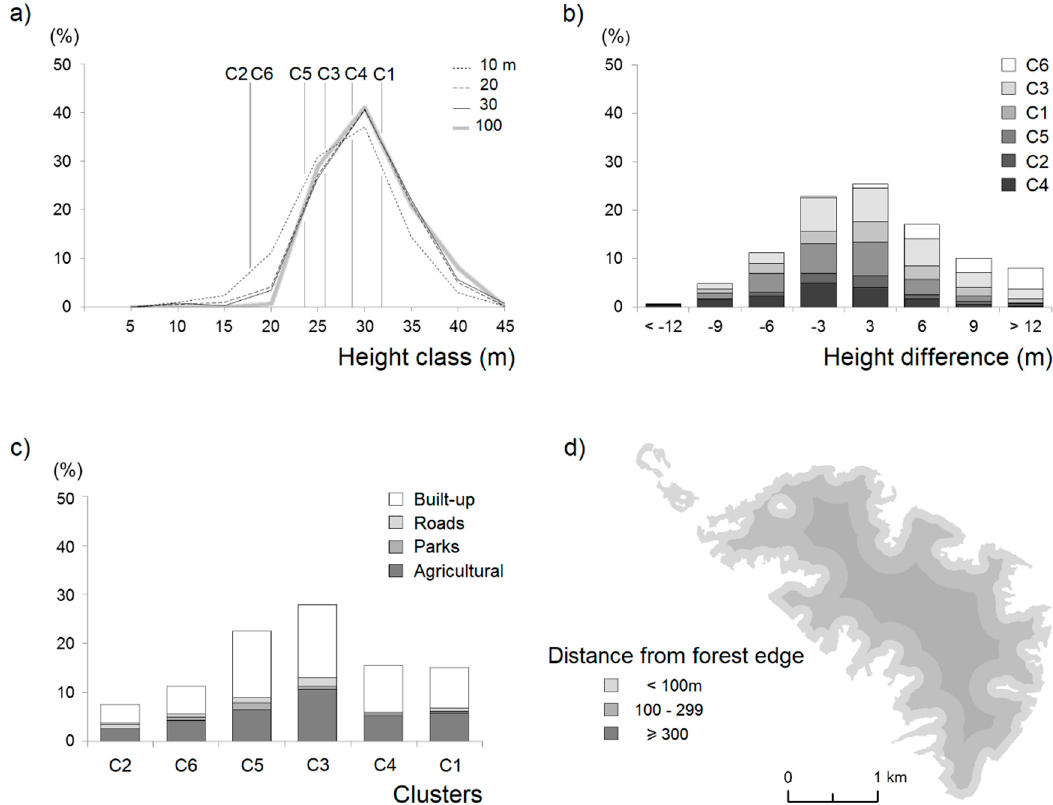
Figure 5. The proportion of canopy cover at di ff erent height levels of trees in 10 m polygons 10, 20, and 30 m from the forest edge and within a distance of 100 m in the direction of the interior forest area ( a ). Depicted are the average heights of the dominant trees in clusters at the forest edge ( a ); height di ff erences between the tallest trees in the first and second forest edge belt ( b ); and the lands bordering on the forest edge ( c ); in the area of the Golovec forest patches ( d